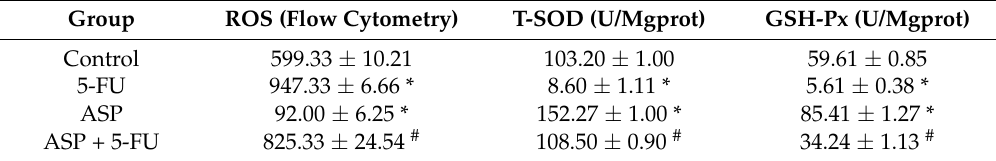
Table 1. The levels of ROS, T-SOD, and GSH-PX in HS-5 cells (X ± S, n = 3).